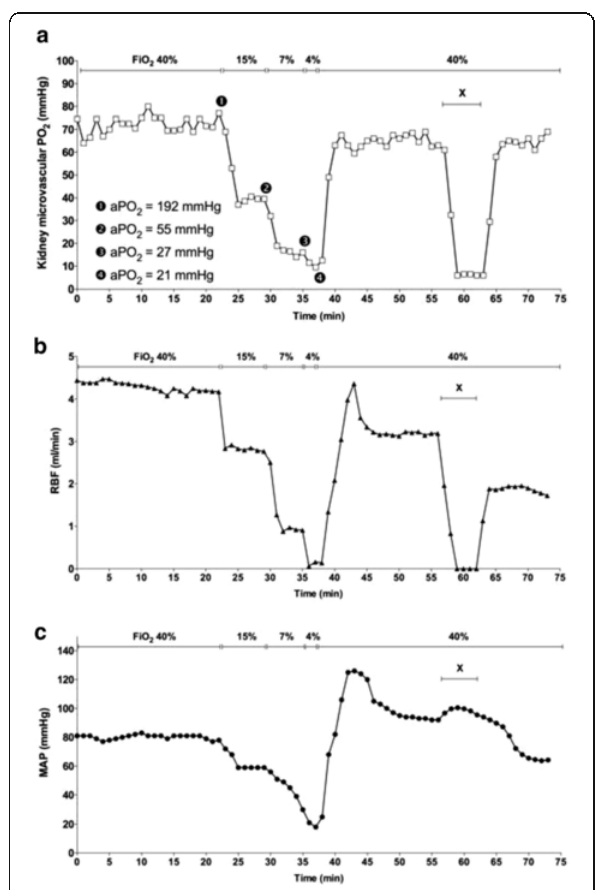
Fig. 17 (abstract A30). Trends in kidney μ PO2 during hypoxia and ischemia